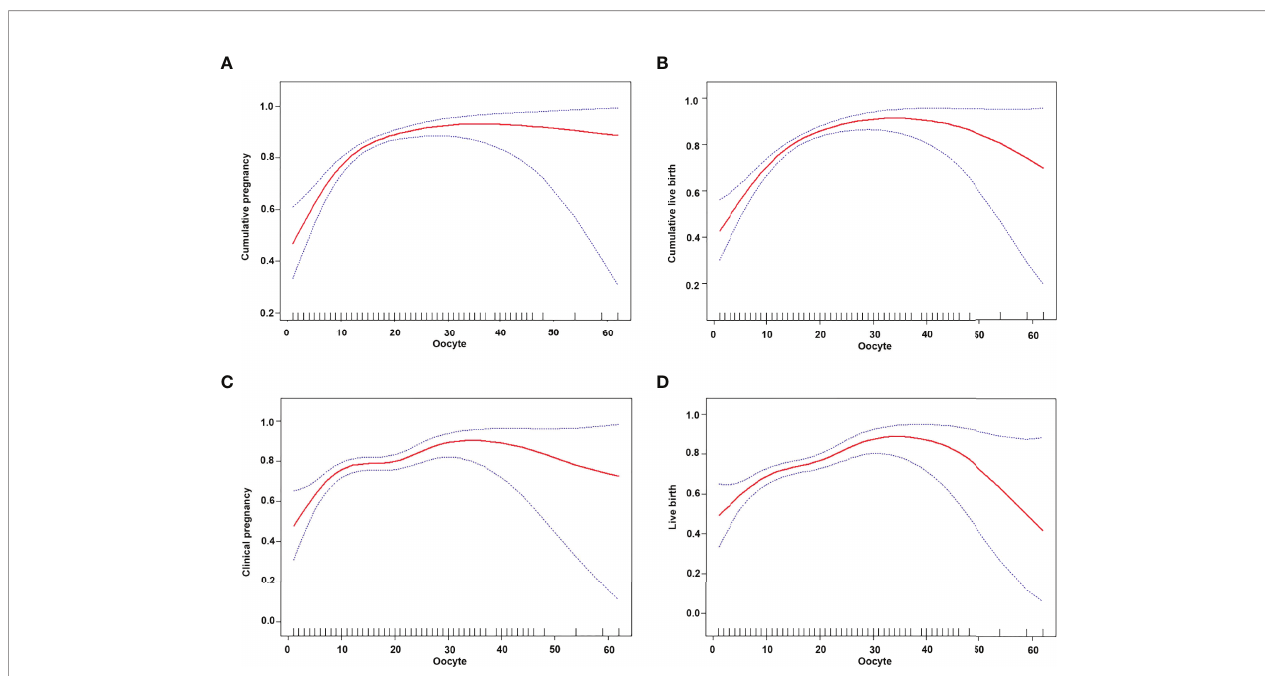
FIGURE 2 | Curve fi tting between the number of oocytes retrieved and clinical outcomes. The adjusted smoothed plots between the number of oocytes retrieved with the cumulative pregnancy rate, the cumulative live birth rate, the clinical pregnancy rate, and the live birth rate are based on a two-piece-wise regression model (A – D) . The nonlinear relationship between the number of oocytes retrieved and the cumulative pregnancy rate, the cumulative live birth rate, the clinical pregnancy rate, and the live birth rate, respectively. Adjustment factors included age, BMI, bFSH, bE2, dose of Gn, type of PCOS, years of infertility, and cycle outcome. The solid and dashed lines represent the estimated values and their corresponding 95% con fi dence intervals.